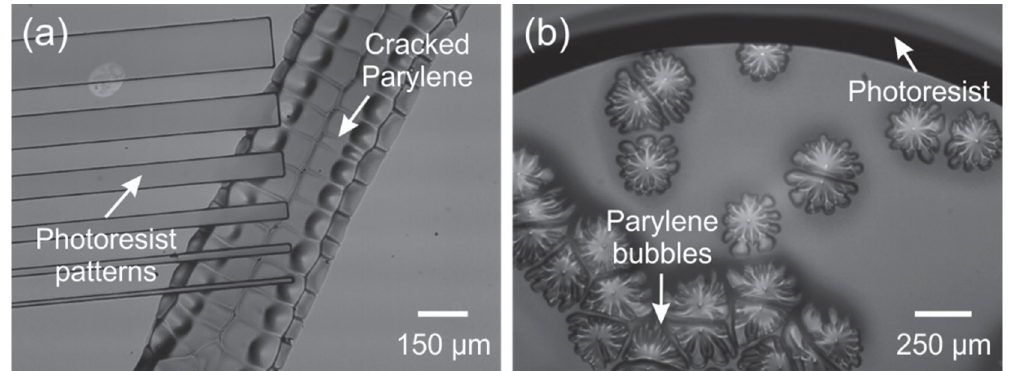
Figure 4. Images of Parylene damage due to high heat or radiation exposure. ( a ) Cracked Parylene after development and soft baking at 115 °C for 3 min; and ( b ) air bubbles appeared under the film, during hard bake at 90 °C for 15 min, in regions previously exposed to UV light during lithography.